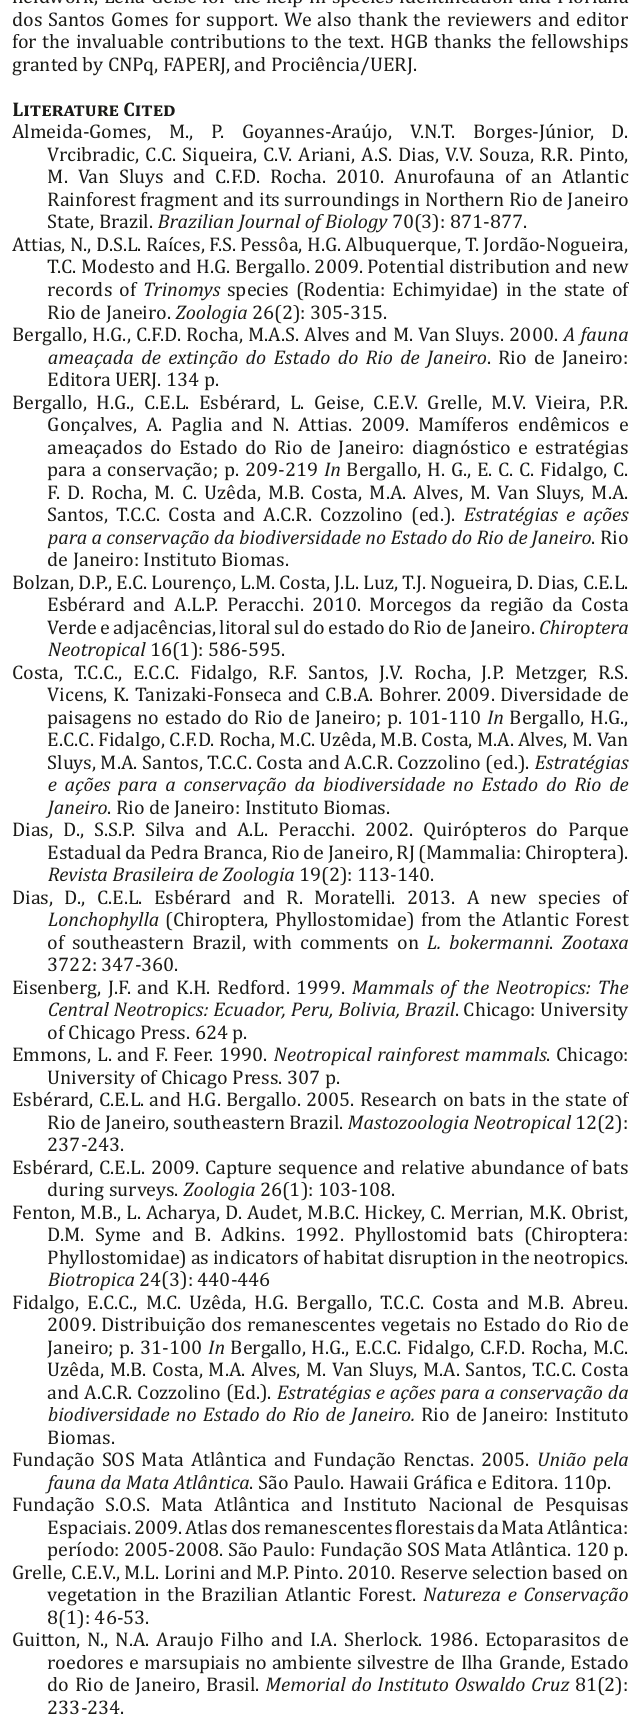
Figure 2. Photo showing the presence of the bat the municipality of Cambuci, state of Rio de Janeiro. Photo: Julia Lins